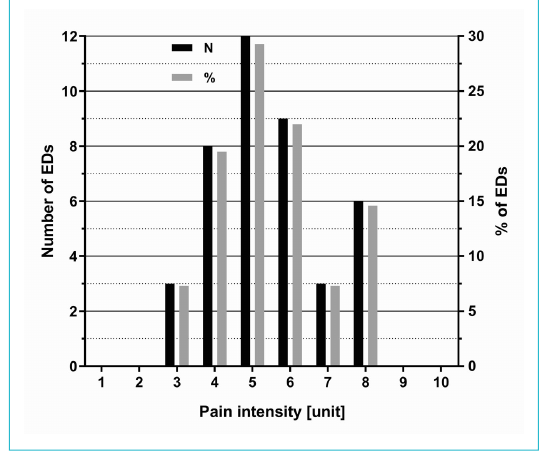
Figure 3: Pain threshold to initiate opioids in nurse-initiated anal- gesia protocols.